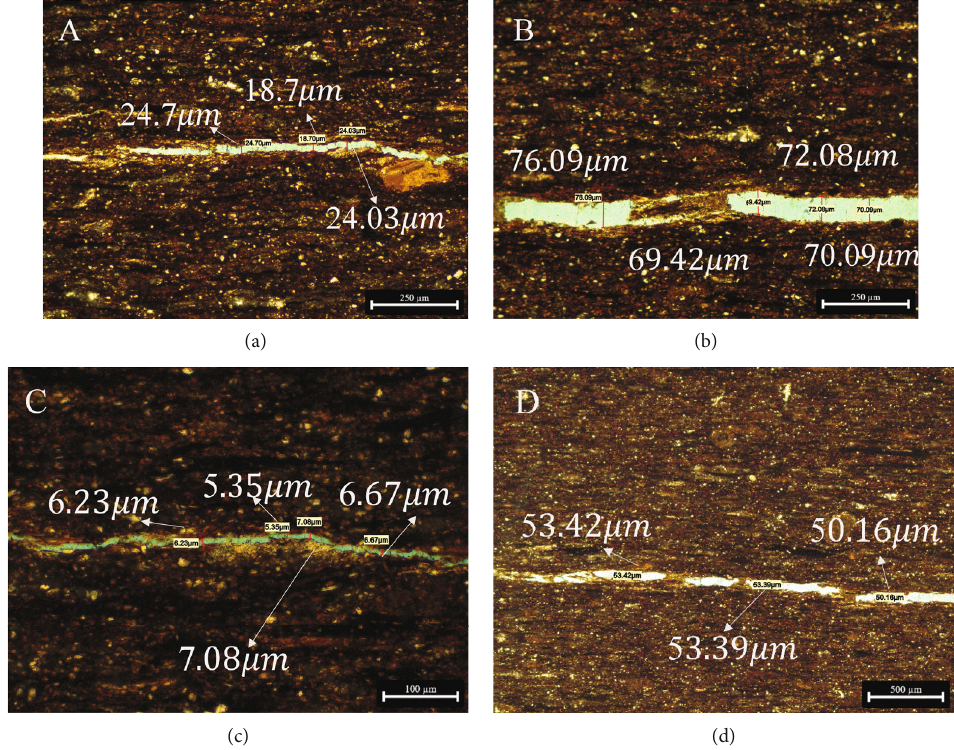
Figure 9: Fracture images with di ff erent apertures as observed from the thin section petrography by Leica DM 750P: (a) between 18.7 and 24.7 μ m, (b) between 69.4 and 76.1 μ m, (c) between 5.35 and 7.08 μ m, and (d) between 50.2 and 53.4 μ m.